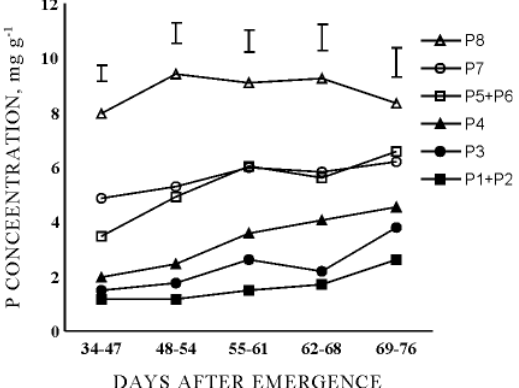
Figure 3. Phosphorus concentration in senesced leaves during the growth cycle of common bean plants grown at eight P levels applied to the soil (in mg kg -1 P): P1 5, P2 10, P3 20, P4 40, P5 80, P6 160, P7 320 P8 640; some P levels were grouped. Vertical bars represent the least significant difference (Tukey test at 0.05), and compare P levels within each week.